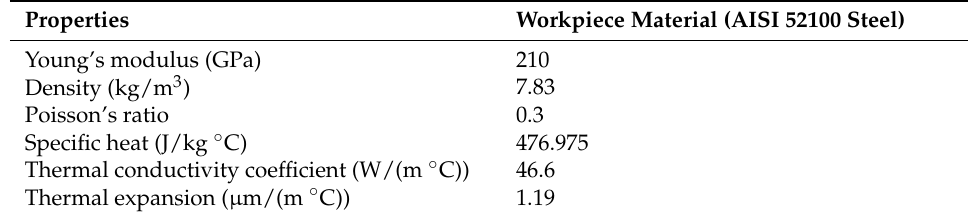
Table 4. The mechanical and thermal properties of the AISI 52100 steel [73].